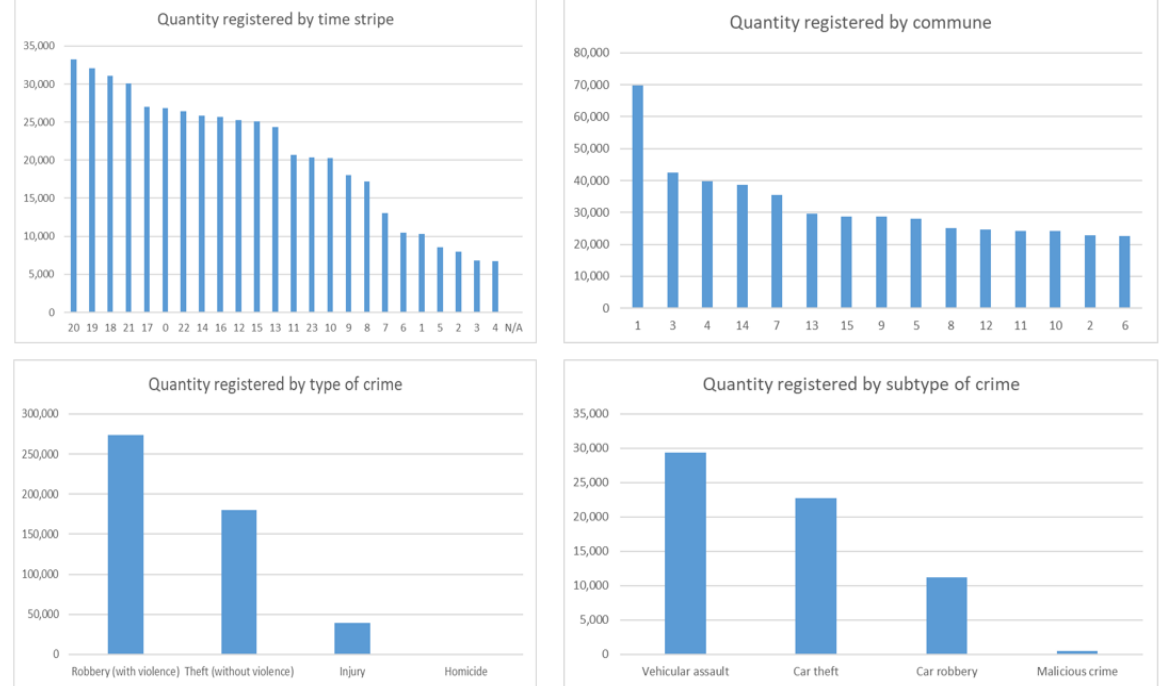
Figure 2. Non-uniform distribution of data. Source: Author’s elaboration.